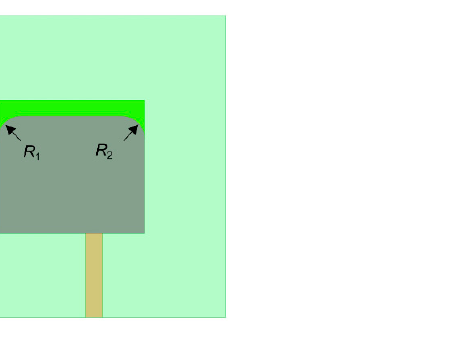
Figure 5. The optimized antenna structure with considering the wetting factor.